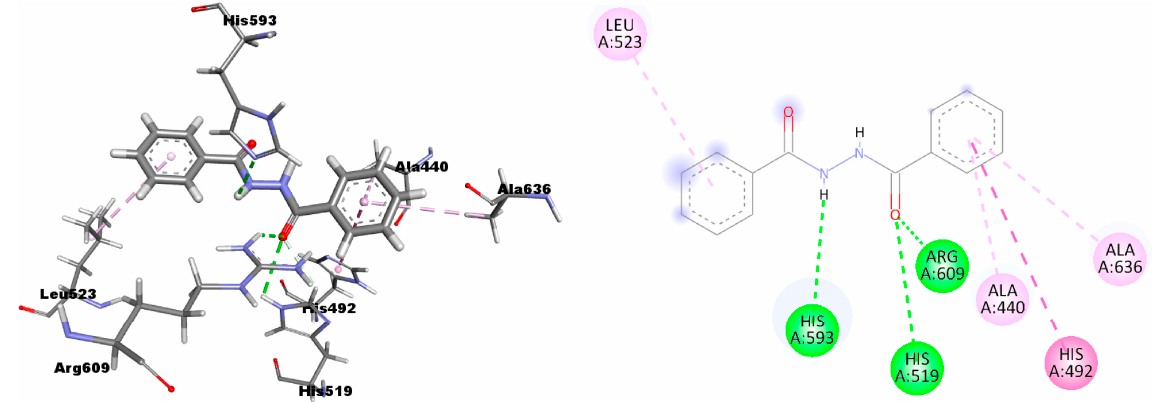
Figure 4. 3D and 2D pictures of the DBH interactions within the urease receptor.